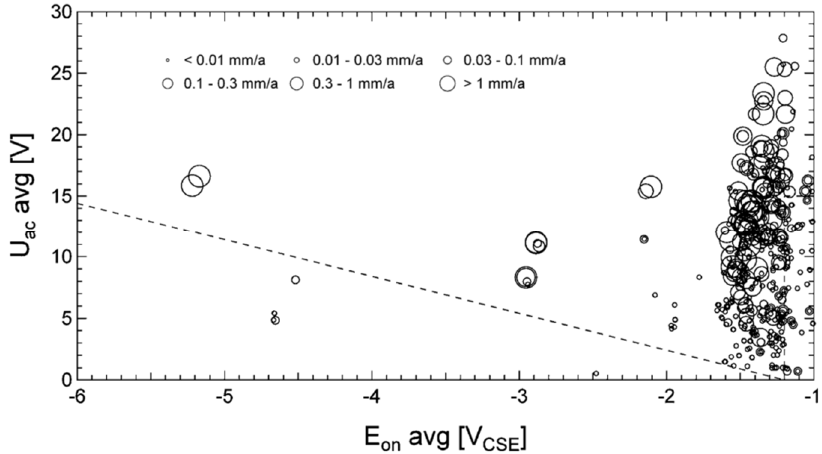
Figure 8. Protection criterion based on AC voltage and ON potential, as proposed by Büchler [61]. The region below the dotted lines corresponds to acceptable AC interference conditions.